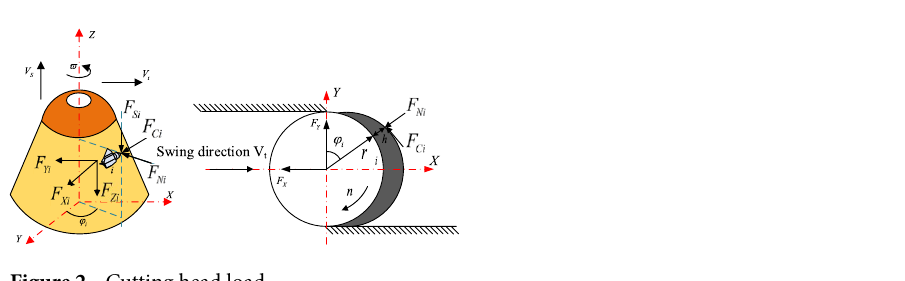
Figure 2. Cutting head